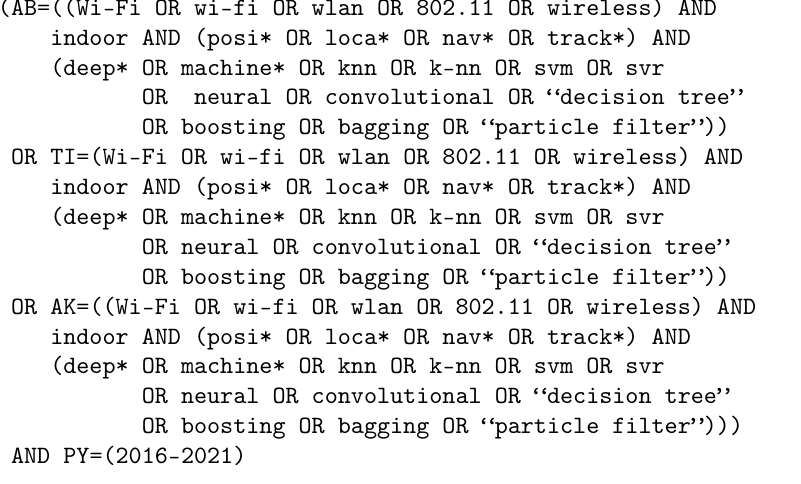
Figure 2. Query for Web of Science